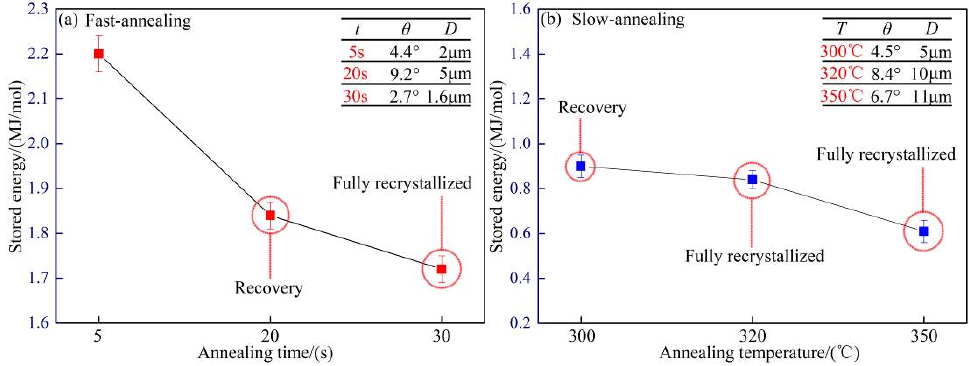
Figure 6. Semi-quantitative calculation of stored energy during annealing ( a ) fast annealing; ( b ) slow annealing.